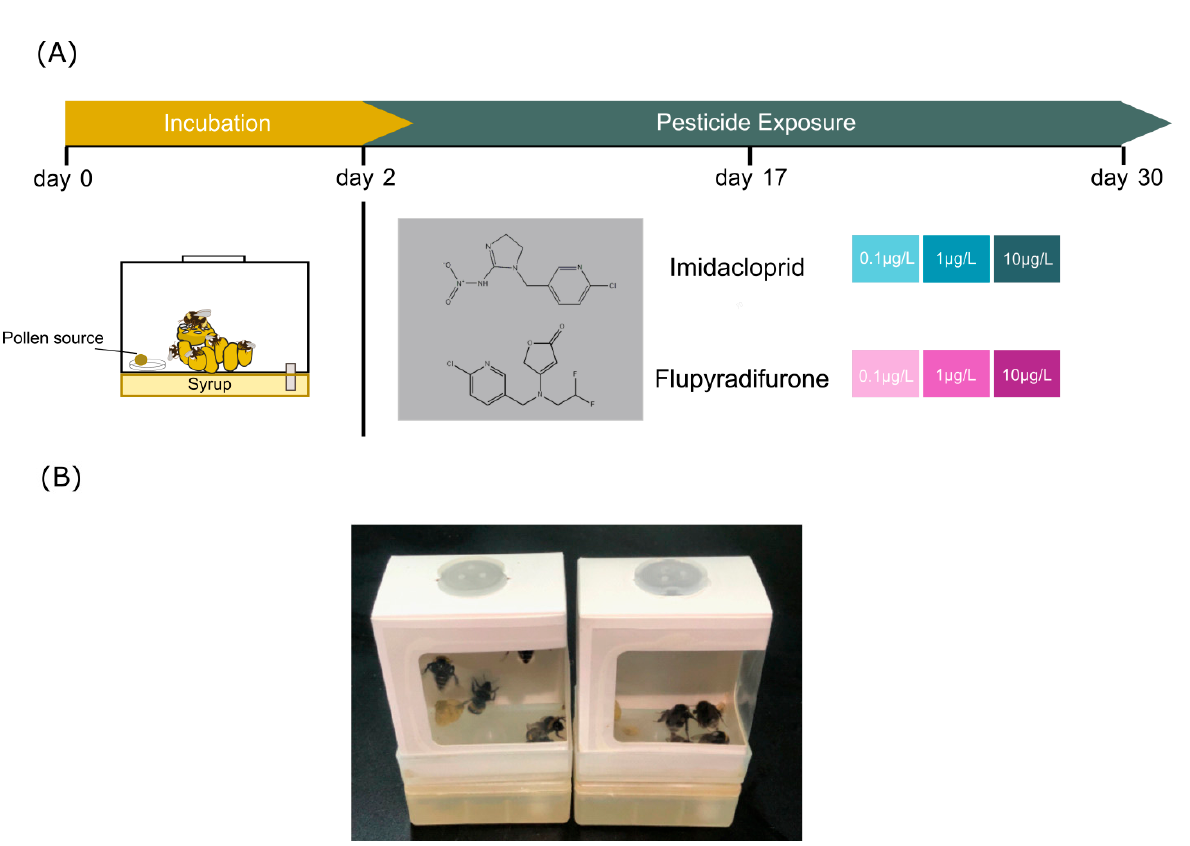
Figure 1. Scheme of experiment. ( A ) Bumblebees and queenless microcolonies were generated from pupae. They were fed with imidacloprid and flupyradifurone, separately, for 15 days prior to sacrifice and harvest of gut samples. ( B ) Capture of microcolony in the lab.